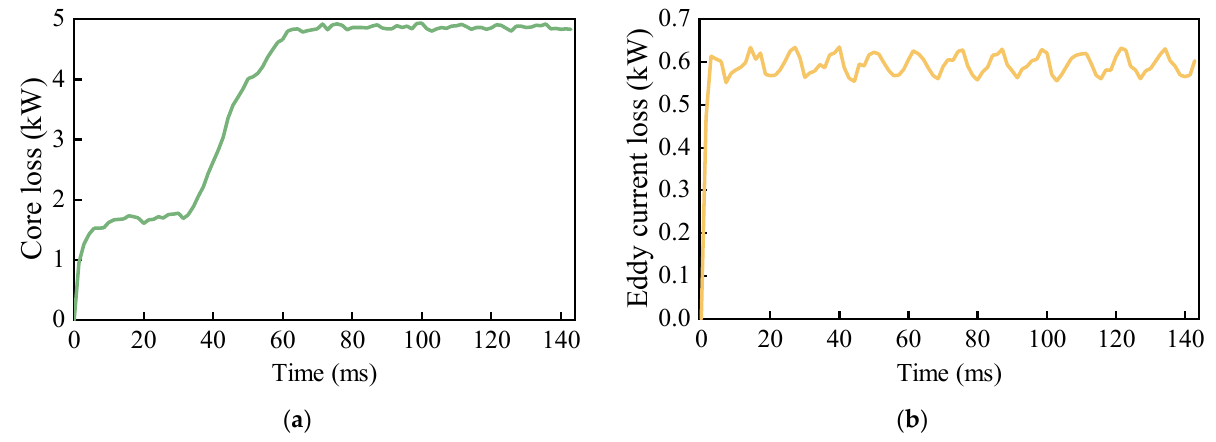
Figure 19. The core loss and eddy current loss of PM in final scheme: ( a ) core loss; ( b ) eddy current loss of the PM.